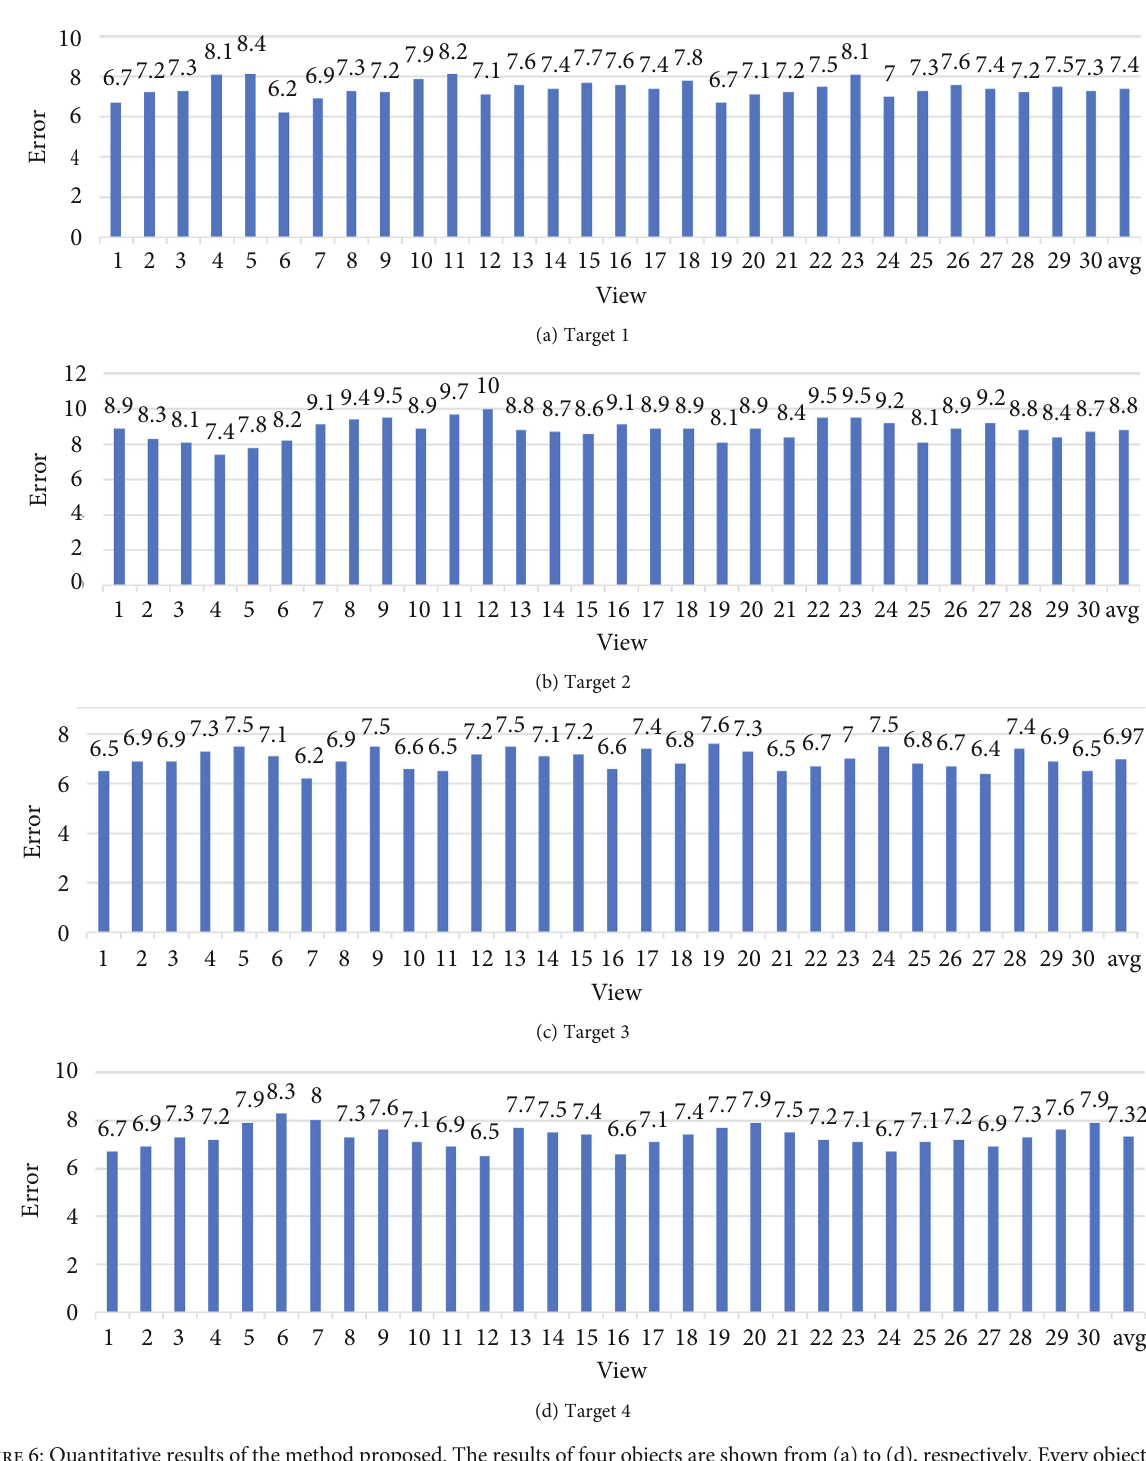
Figure 6: Quantitative results of the method proposed. The results of four objects are shown from (a) to (d), respectively. Every object has 30 test images from di ff erent views. The performance of the method is evaluated by